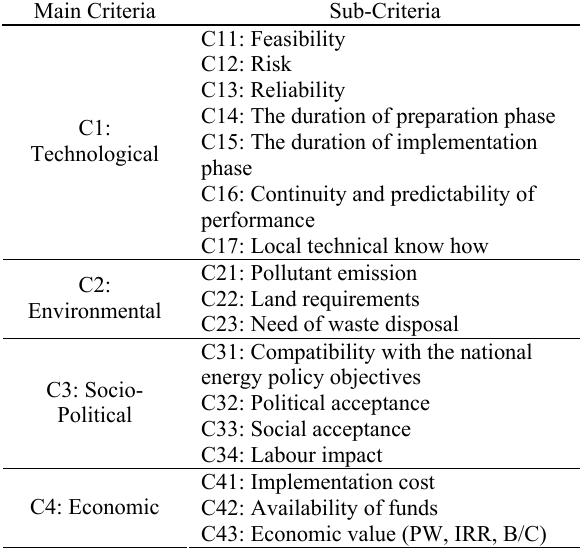
Table 1. Criteria taken into account to select the most appropriate renewable energy alternative Main Criteria